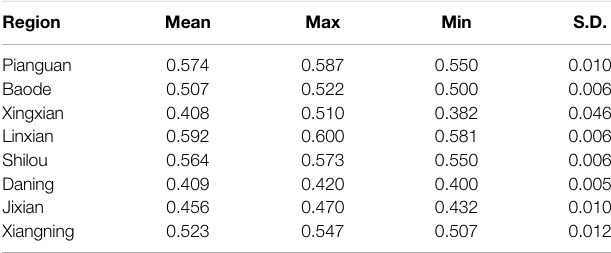
TABLE 1 | Statistics of the mathematical characteristics of the hypsometric integral (HI) of each region. Region Mean